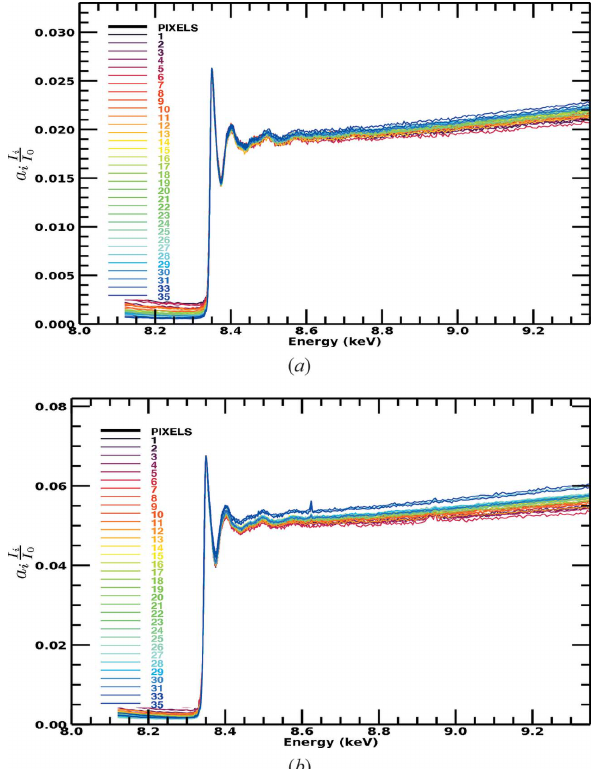
Figure 13 ( a ) The i -pr spectra normalized for detector pixel efficiency. ( b ) The n -pr spectra normalized for detector pixel efficiency. Normalization for pixel efficiency [ " det ( E )/ " mon ( E )] makes a significant improvement in the dispersion between spectra. However, significant dispersion and variance remain in the pre-edge region and increase at higher energies. Furthermore, the spectral trend with energy is not in agreement with the transmission data (Fig. 2). Typical applications of this limited approach pin spectra at the edge or pre-edge and diverge away from this empirical pin. This methodology is not sufficient for high-accuracy data